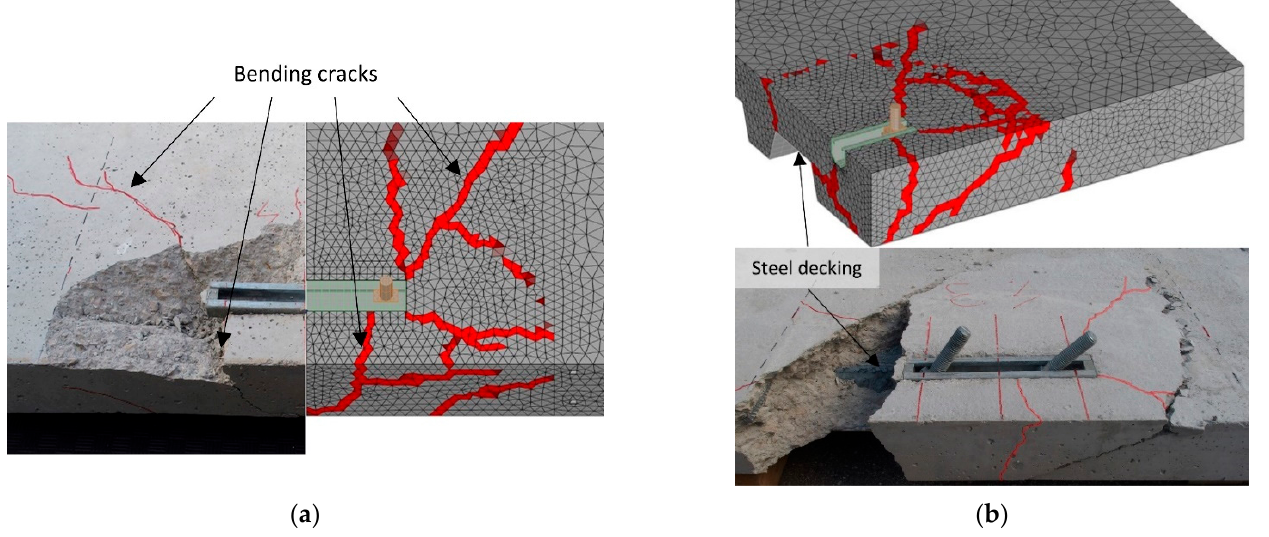
Figure 3. Comparison between experimental and numerical breakout patterns for: ( a ) plain concrete slab; ( b ) composite slab.